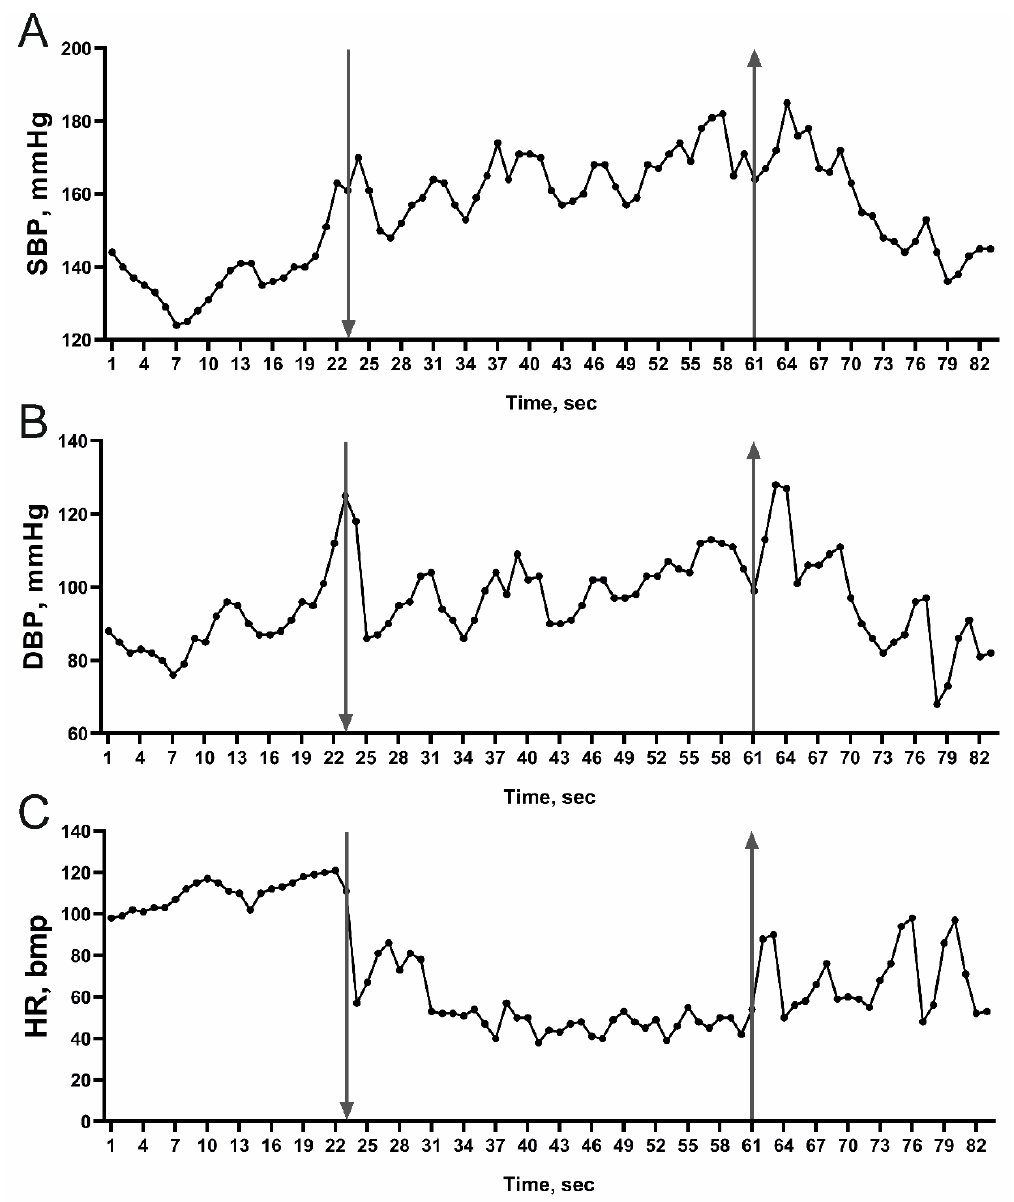
Figure 1. Representative dynamic of blood pressure and heart rate changes in the subject M during imitation of the diving reflex. Arrow pointing down indicates the beginning of face submersion; arrow pointing up indicates the end of face submersion. ( A ) Changes in systolic blood pressure (SBP) during the imitation of the diving reflex. ( B ) Changes in diastolic blood pressure (DBP) during the imitation of the diving reflex. ( C ) Changes in heart rate (HR) during the imitation of the diving reflex. Further, to evaluate lung blood flow, we used the following parameters: RI—rheographic index of the right pulmonary arterial system, which indirectly indicates the level of blood filling into the pulmonary artery during right ventricle blood output; DCI—dicrotic index, which is an indirect indication of the vascular tone in pulmonary artery large vessels; and DSI—diastolic index, which helps to characterize the ratio of venous drainage to arterial blood supply in the right lung [35]. While no changes were found in RI between the face immersion attempts, DCI and DSI were significantly lower during the face submersion at attempts #1 and #2 but not at attempt #3 (Table 2). Interestingly, 54% of the subjects demonstrated a stable reduction in DCI and DSI, while 41% of the subjects had an unstable reduction in DCI and DSI (i.e., at least one attempt at face submersion was not